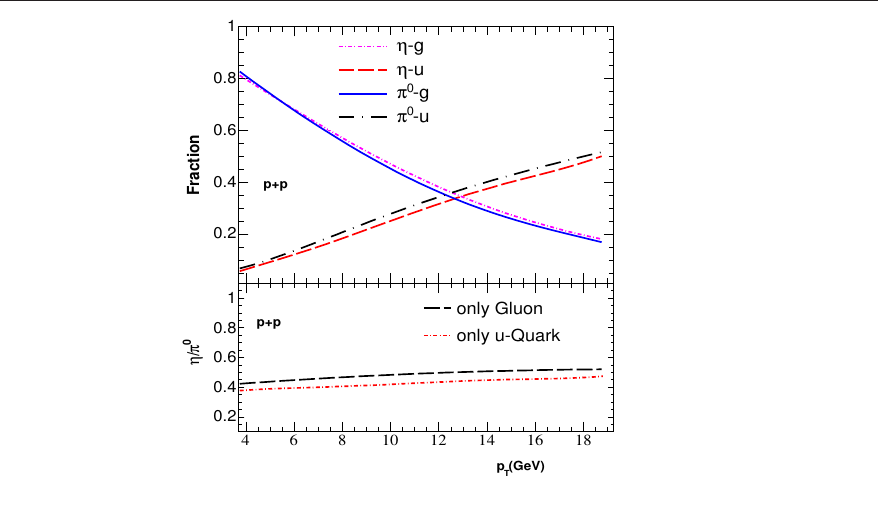
Figure 1. Contribution fractions of π 0 and η productions from quark and gluon fragmentations in p + p collisions at NLO with √ s NN = 200 GeV